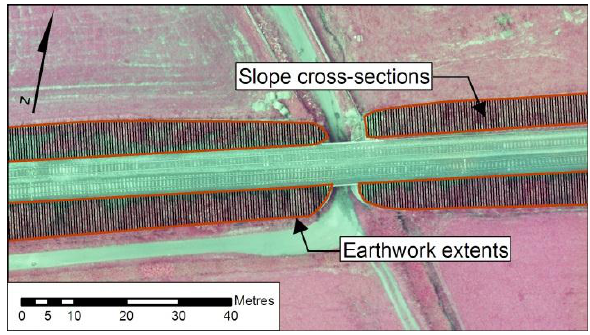
Figure 2. Slope cross-sections, clipped to earthwork polygons.